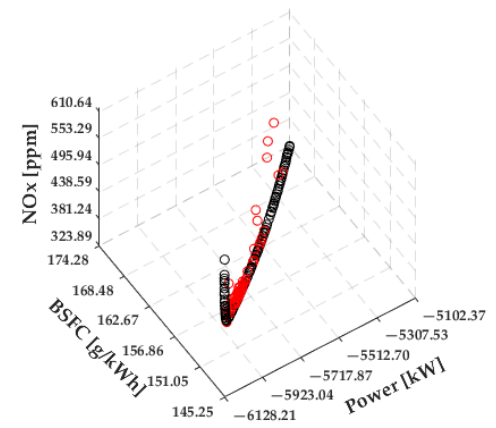
Figure 8. Overall distribution of goals.